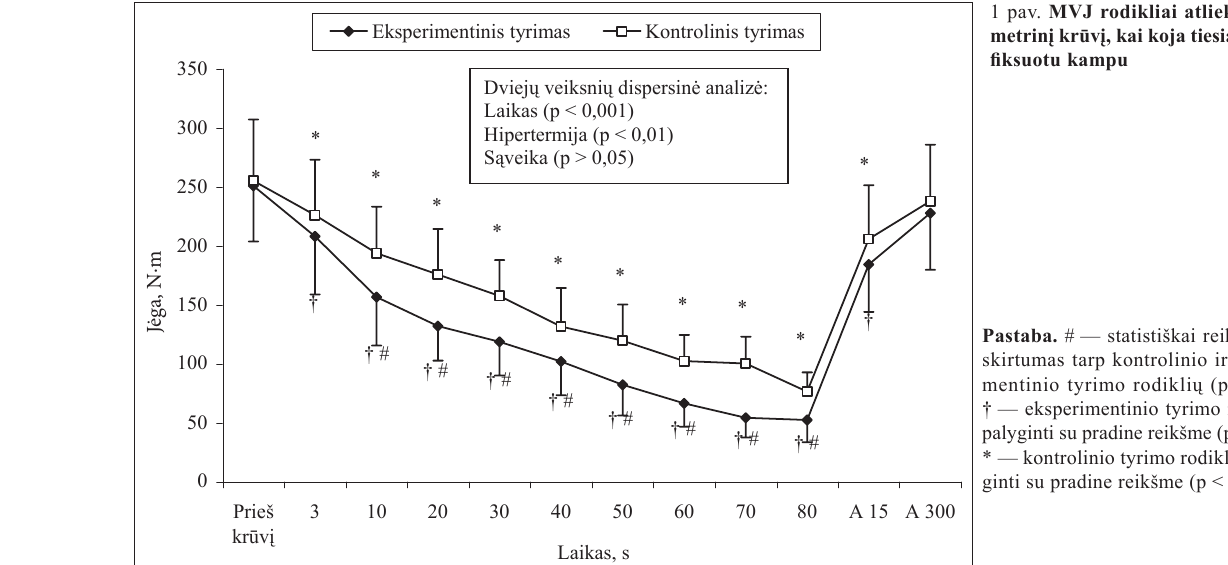
Pastaba. # — statistiškai reikšmingas skirtumas tarp kontrolinio ir eksperi- mentinio tyrimo rodikli ų (p < 0,05); † — eksperimentinio tyrimo rodikliai, palyginti su pradine reikšme (p < 0,05); * — kontrolinio tyrimo rodikliai, paly- ginti su pradine reikšme (p <